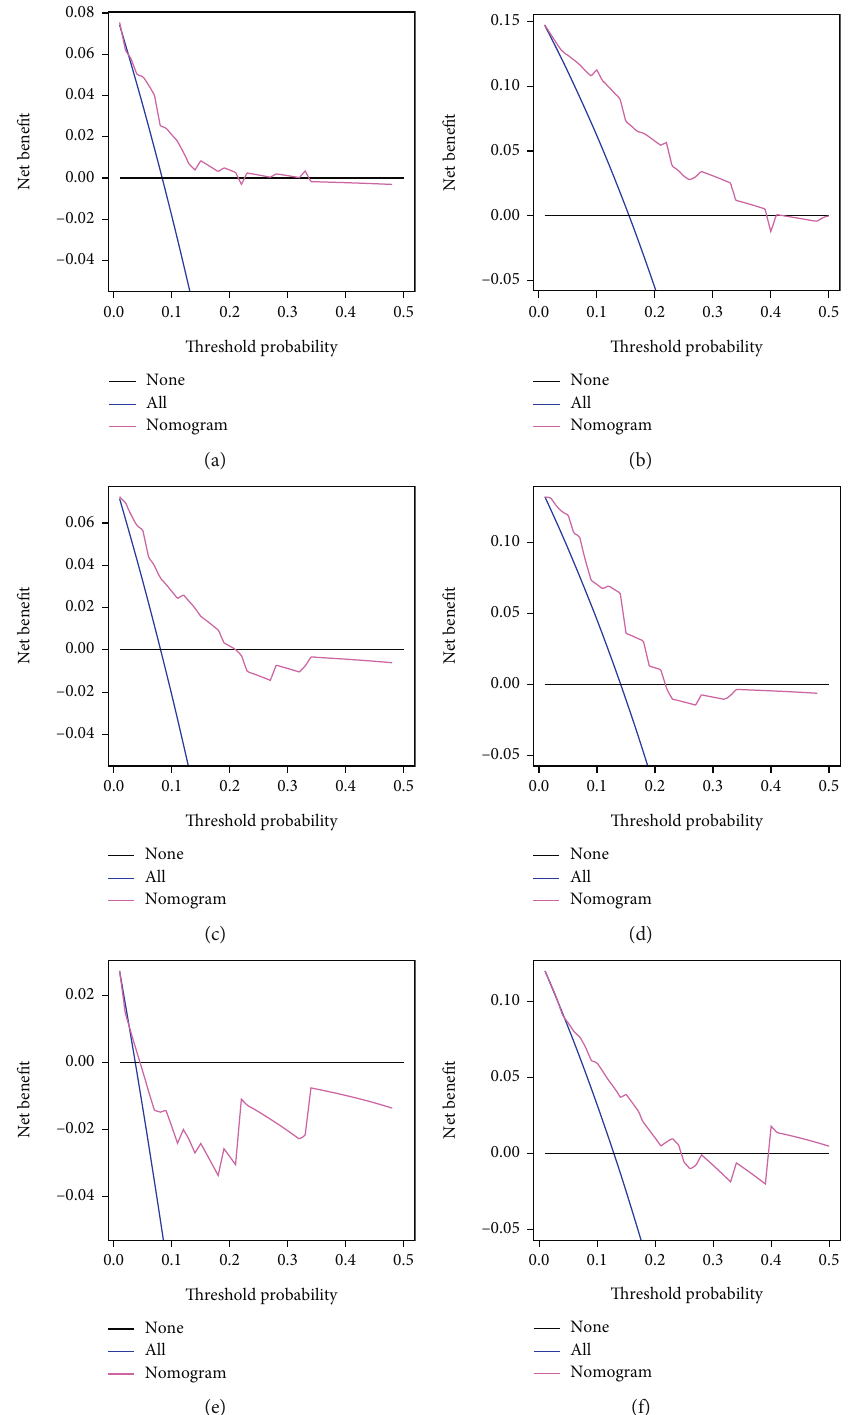
Figure 4: DCA of the nomogram. Decision curves for PFS at (a) 1 year and (b) 3 years in the training cohort, at (c) 1 year and (d) 3 years in the internal validation cohort, and at (e) 1 year and (f) 3 years in the external validation cohort were applied to the nomogram. The x -axis represents the threshold probability. The y -axis measures the net bene fi t. The black line depicts the net bene fi t of the strategy of treating no patients. The blue line depicts the net bene fi t of the strategy of treating all patients. The red line represents the nomogram. The net bene fi t was calculated by subtracting the proportion of all patients who are false positive from the proportion who are true positive, weighting by the relative harm of forgoing treatment compared with the negative consequences of an unnecessary treatment. The threshold probability is where the expected bene fi t of treatment is equal to the expected bene fi t of avoiding treatment. For example, if the possibility of RAP development in a patient is over the threshold probability, then, a RAP treatment strategy should be adopted. Abbreviations: DCA: decision curve analysis; PFS: pneumonia-free survival; RAP: radiation-induced aspiration